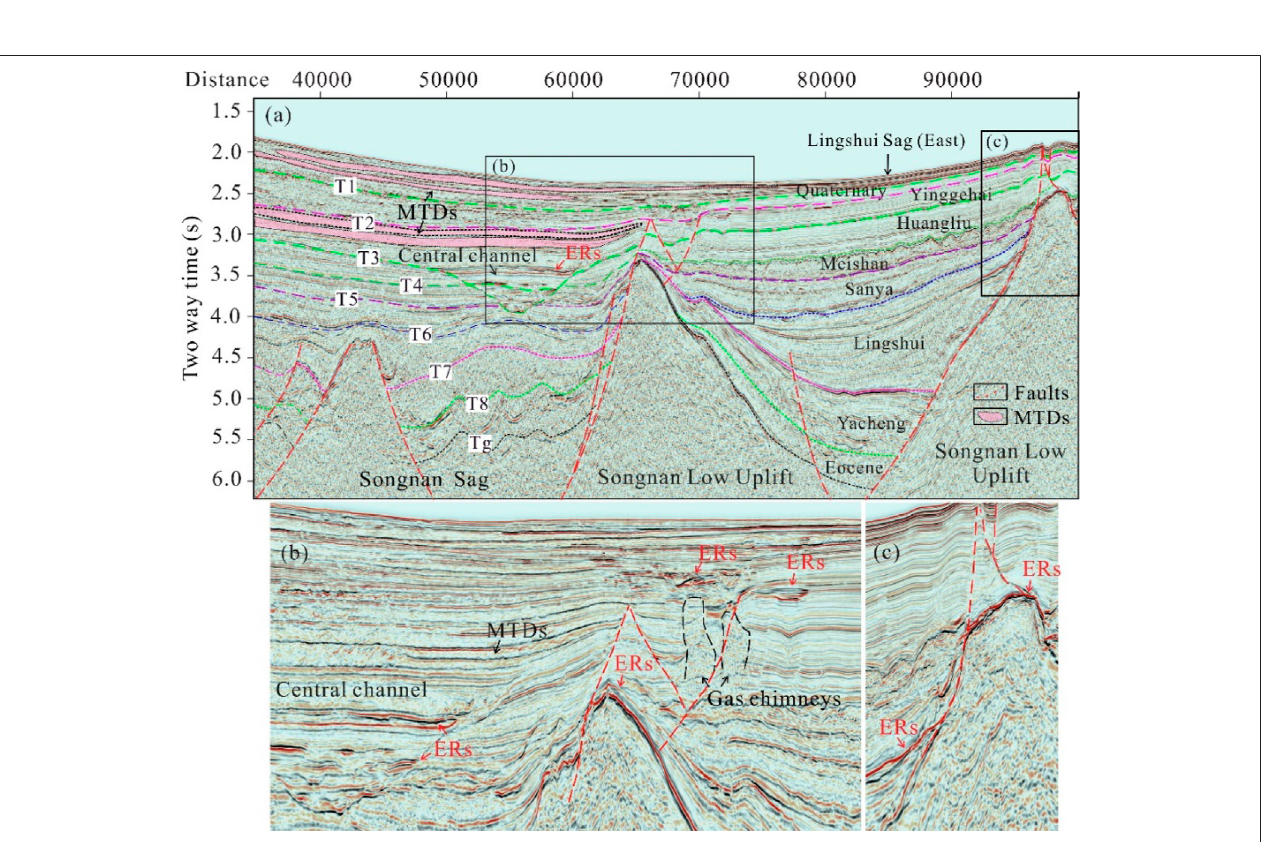
Frontiers in Earth Science |